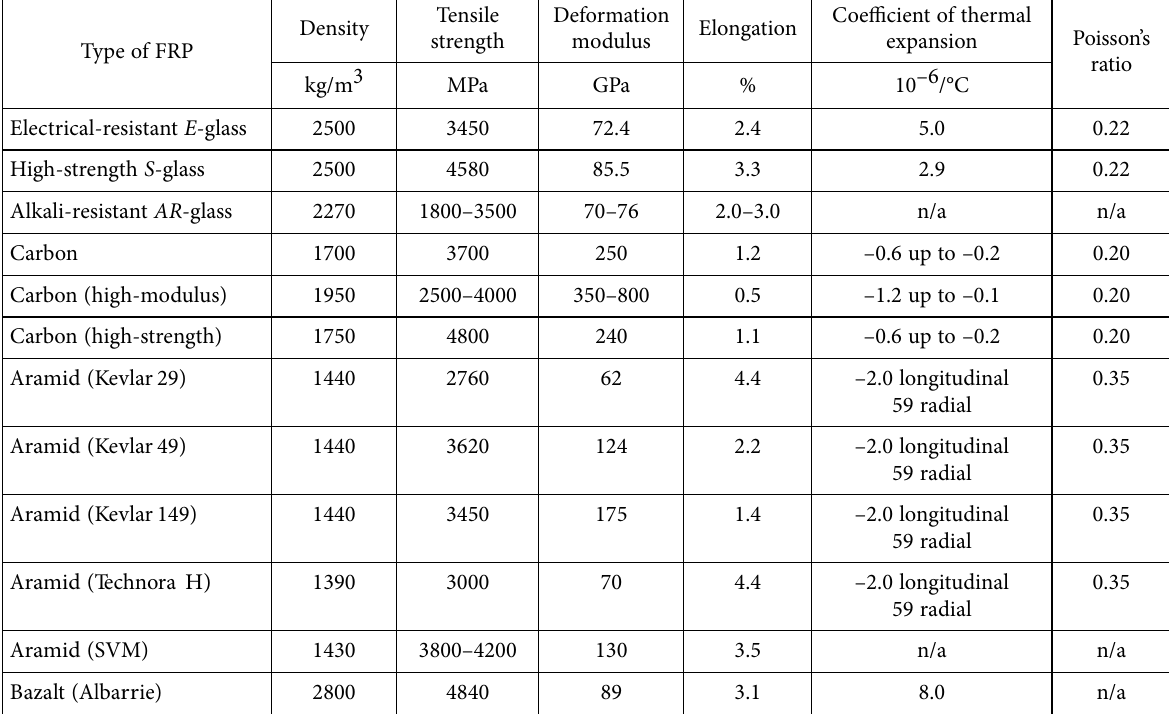
Table 1. Physical and mechanical properties of different